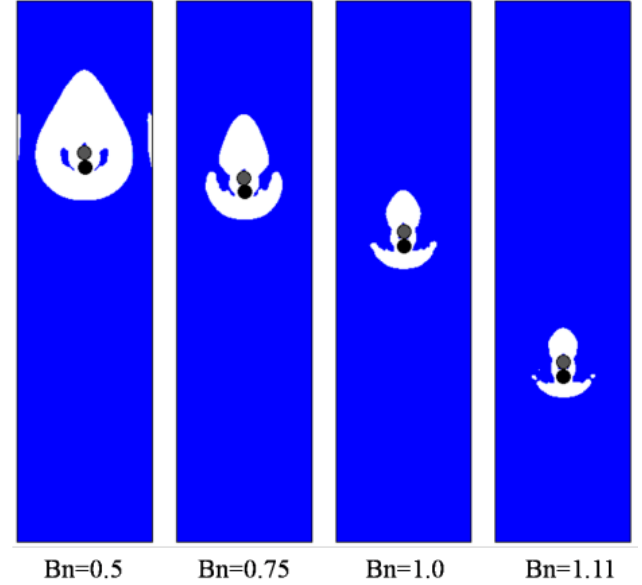
Figure 5. Snapshots at the kissing time of the two circular particles’ sedimentation processes in Bingham fluid with various Bn s (Yielded region: white; Unyielded region: blue).